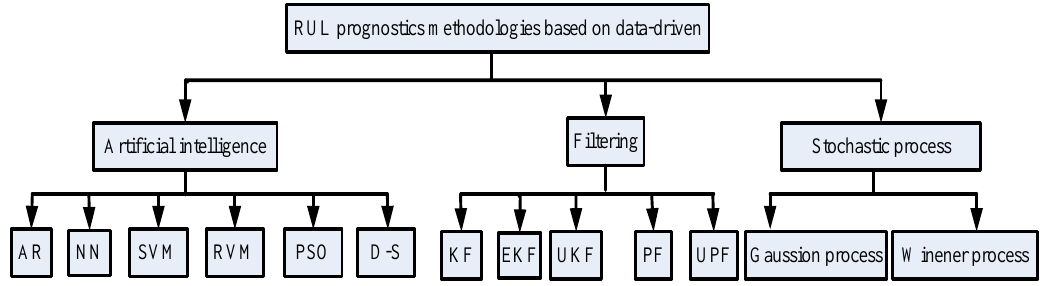
Figure 1. The main remaining useful life (RUL) prognostics methodologies of vehicle lithium-ion batteries. Moreover, the advantages and disadvantages of these three kinds methods shows in Table 1.